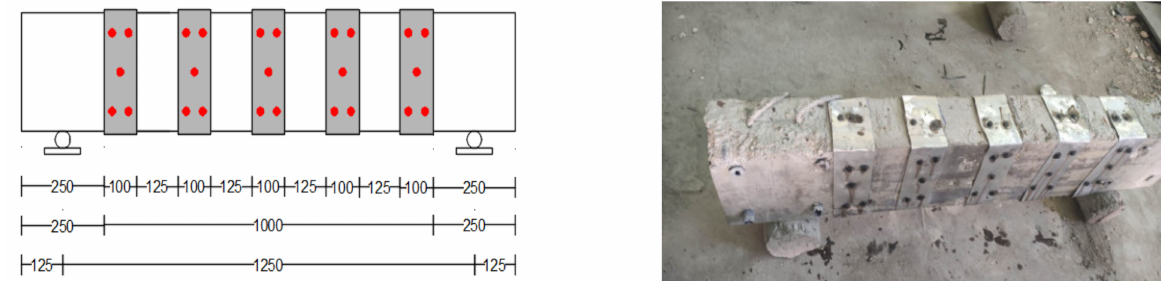
Figure 2. Preparing beam B1-AS.